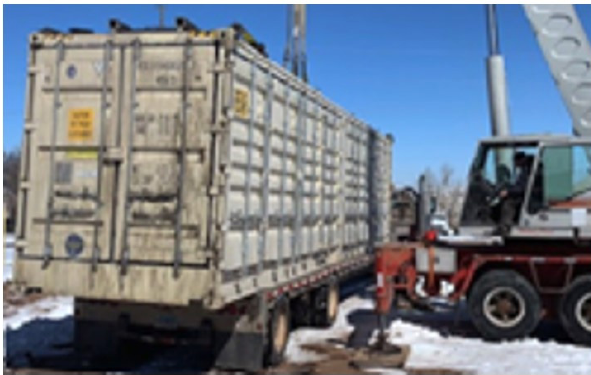
Figure 9. Container-chamber. Source: